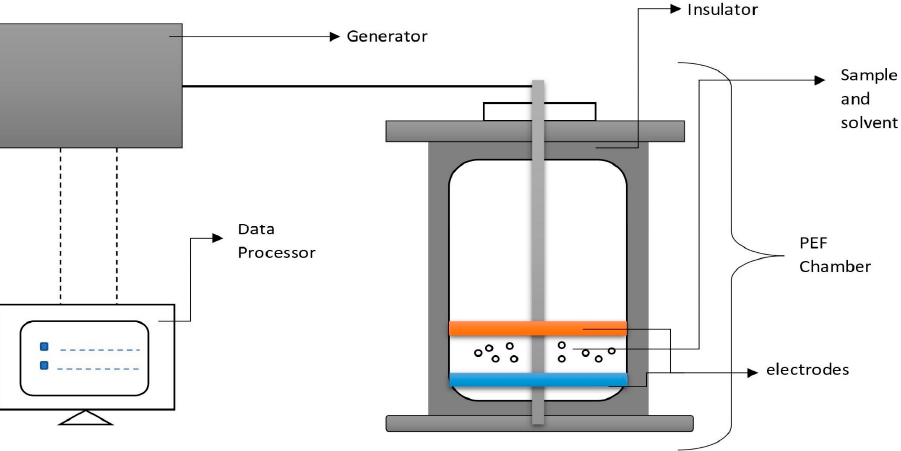
Figure 9. A diagrammatic representation of pulsed electric field extraction.